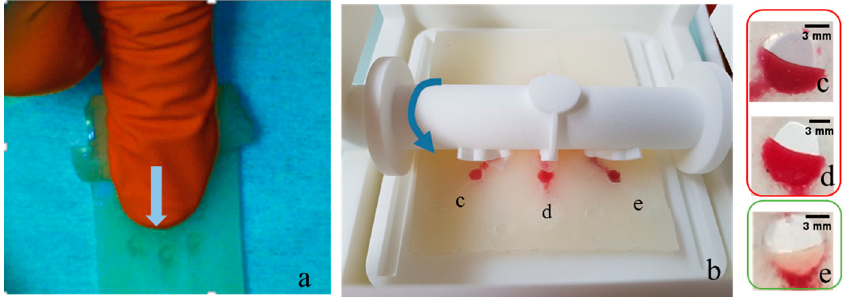
Figure 4. Blood typing test in fully flexible foam-based microdevice which can be manually wrapped for the generation of a Poiseuille flow ( a ); similar effect is obtained with a roller ( b ); Specific typing antibodies embedded in the device allow visualization of the blood type—negative ( c , d ); positive ( e )—in dedicated hollow